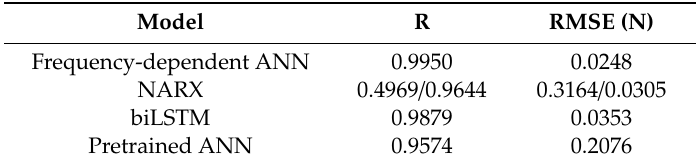
Table 2. Regression coe ffi cients and RMSE for the di ff erent models trained on the academic case with 68 sensors.